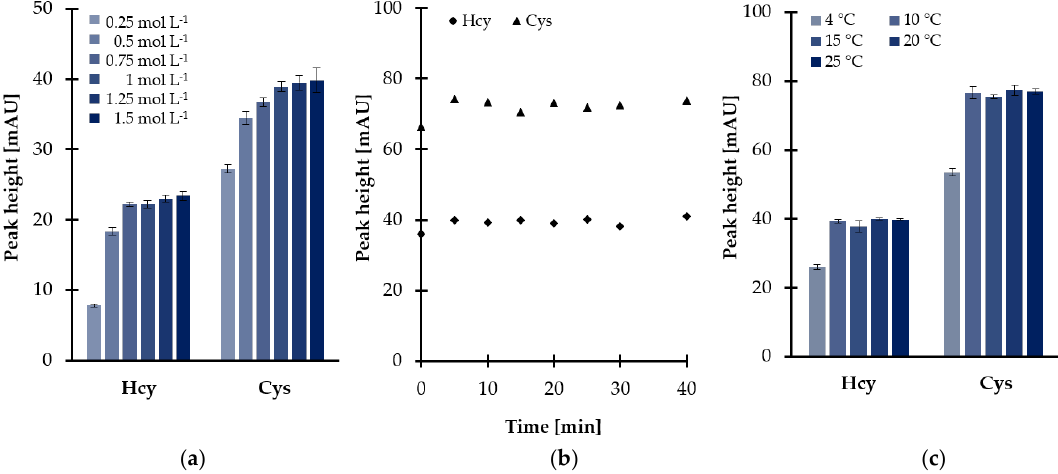
Figure 1. Disulfides reduction yield as a function of ( a ) reagent excess, ( b ) time, and ( c ) temperature, expressed as a peak height of 2-S-lepidinium derivatives of Cys and Hcy. Samples were analyzed according to the procedure based on HPLC-UV measurements [24]. Error bars refer to standard deviation (SD) of the data ( n = 3).